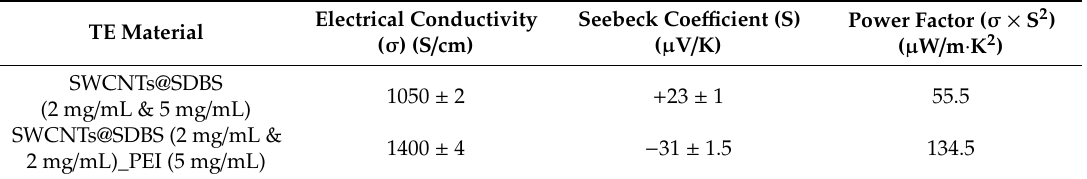
Table 1. Electric and thermoelectric values of both p-type and n-type bucky paper films.